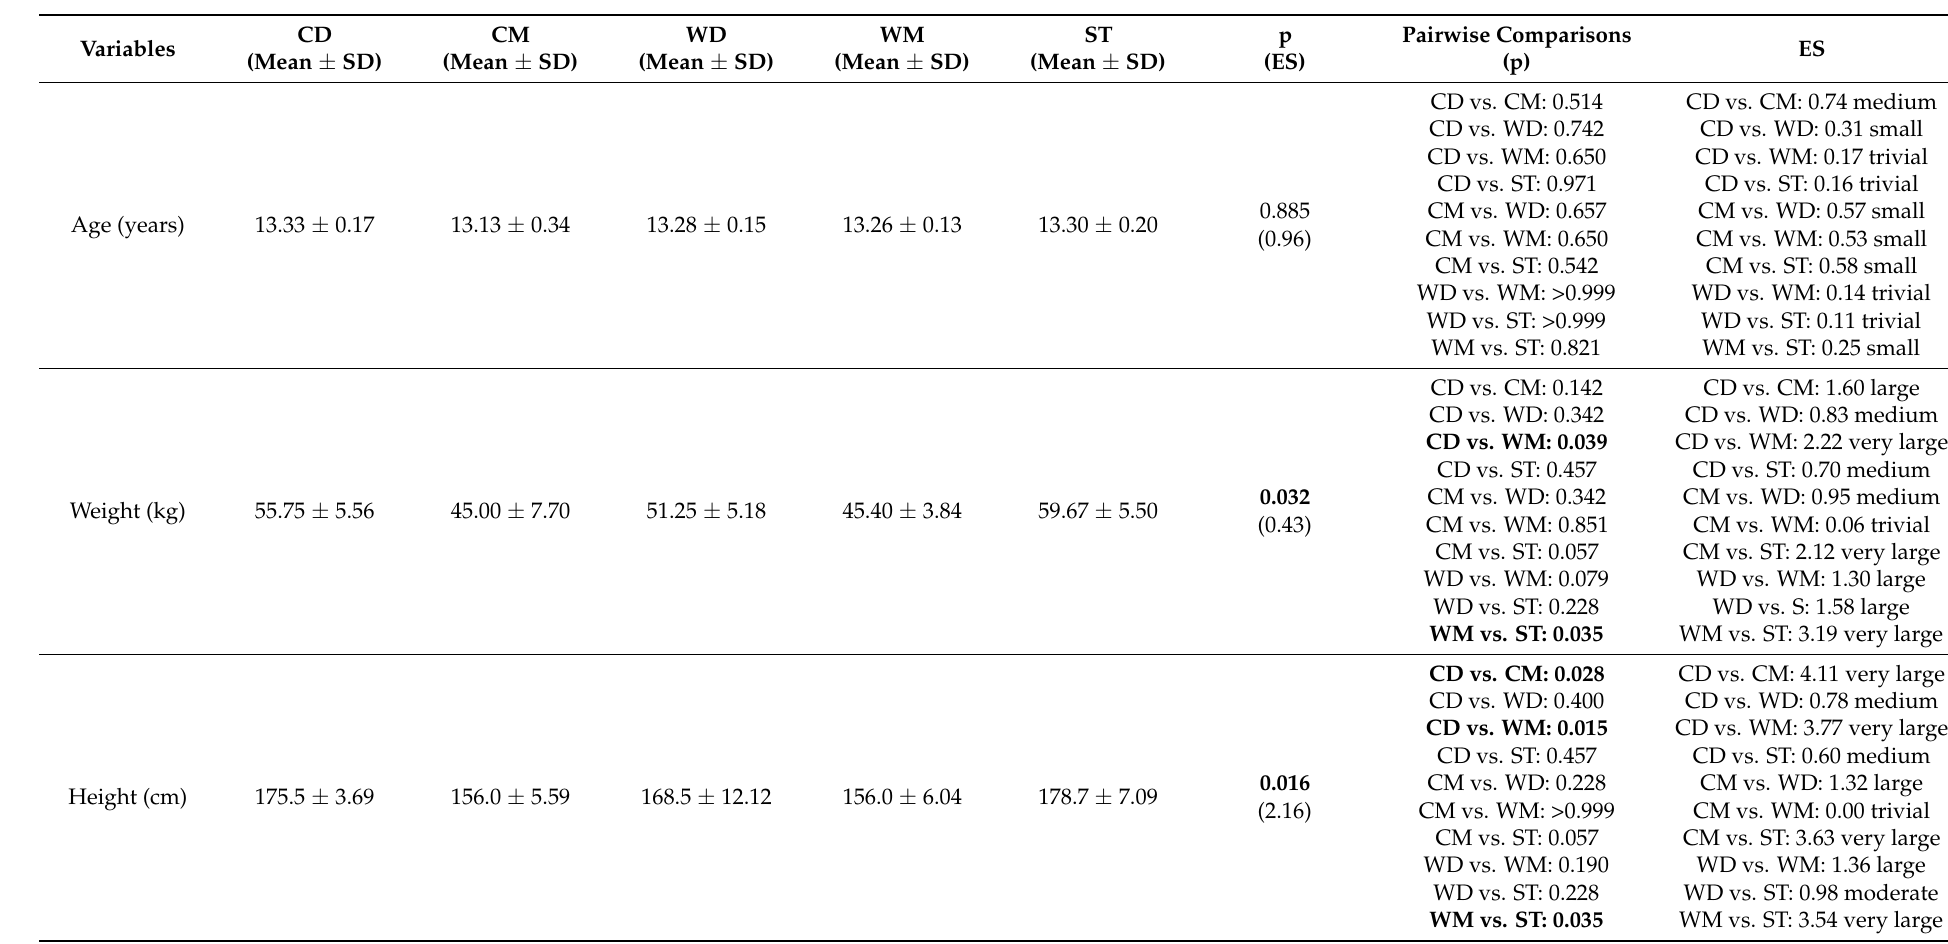
Table 2. Pairwise comparisons between the established subgroups (central defenders vs. central midfielder vs. striker vs. wide defender vs. wide midfielder) on